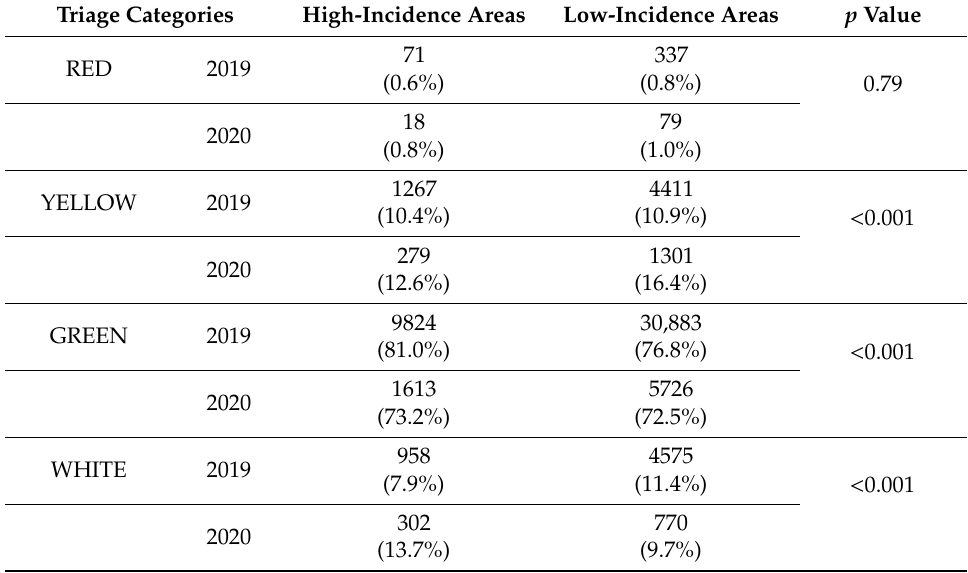
Table 3. Comparison in triage categories between high- and low-incidence areas. Triage